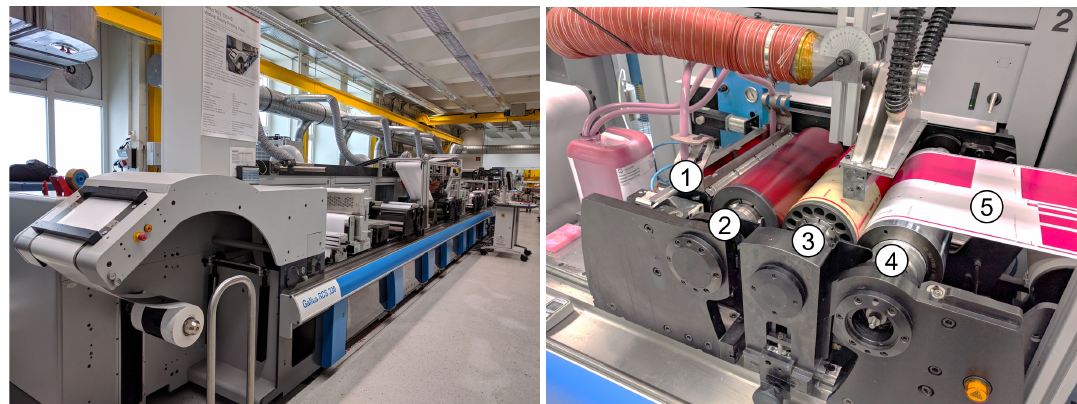
Figure A1. ( Left ) Gallus RCS 330-HD printing press; and ( Right ) Flexo printing module with printing with blade-chamber reservoir (1), anilox roller (2), printing cylinder (3), impression roller (4) and substrate (5).